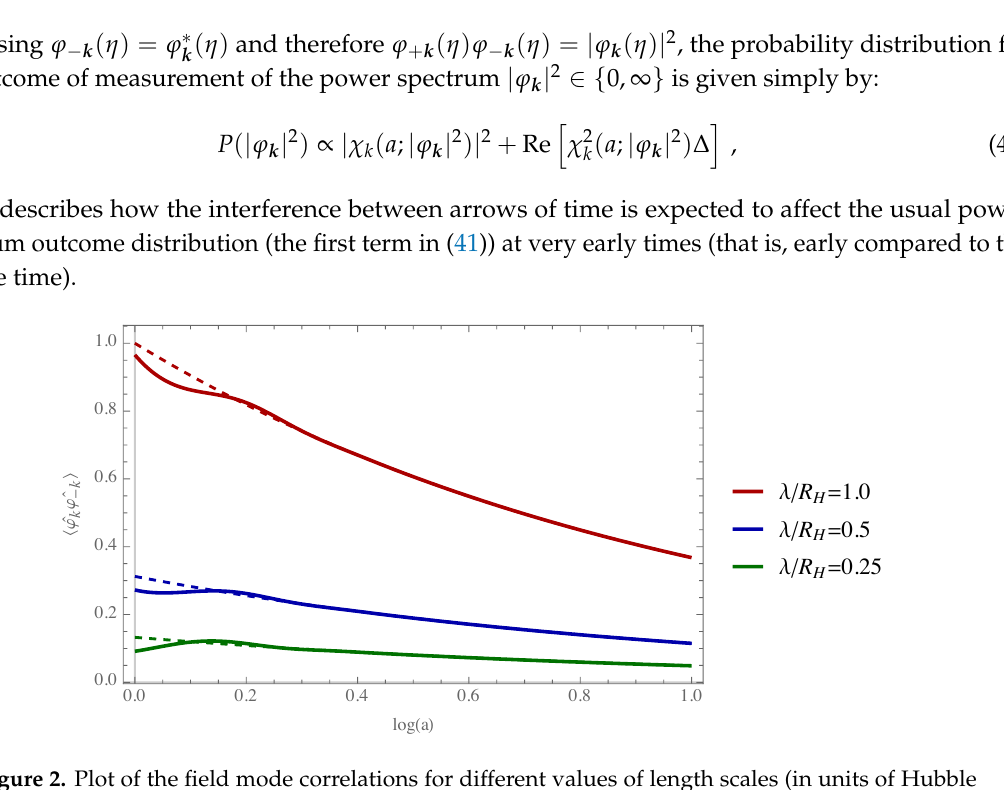
Figure 2. Plot of the field mode correlations for different values of length scales (in units of Hubble radius) as a function of the e-folding (i.e., time in units of Hubble time), superposed on their usual value when interference is not taken into